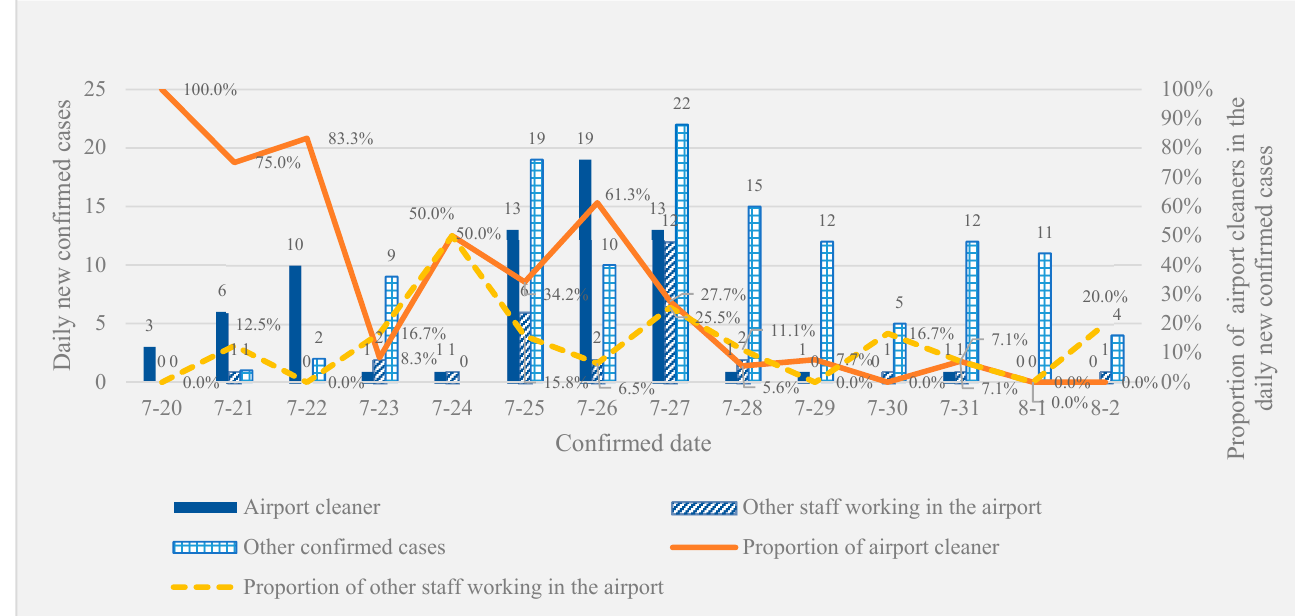
Figure 1. The trends of new local cases confirmed daily from 20 July to 2 August.